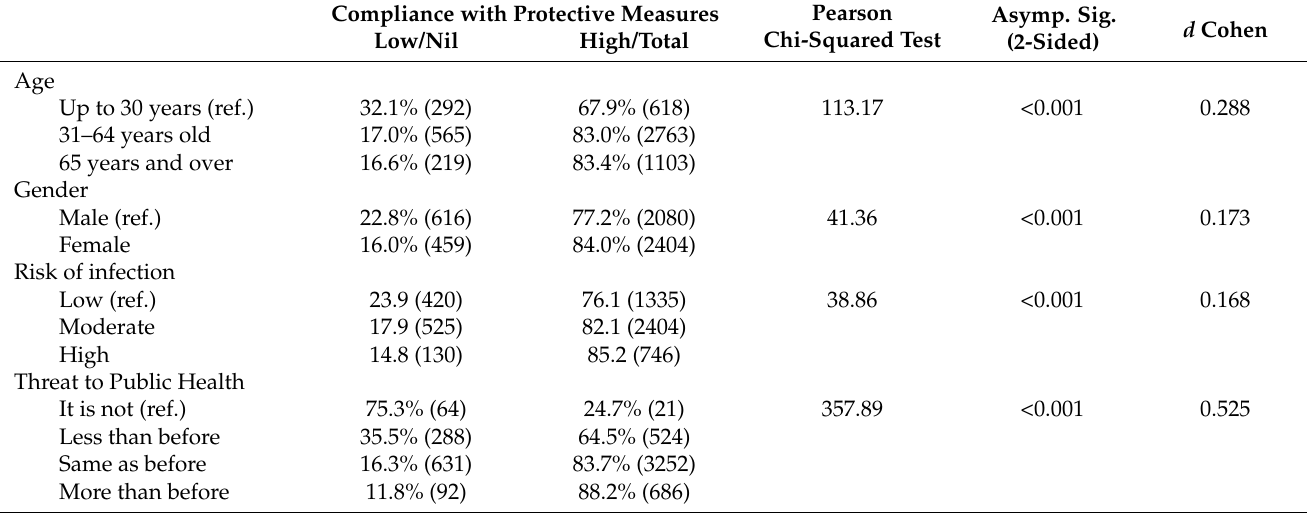
Table 3. Compliance with protection measures distributed according to the different variables.